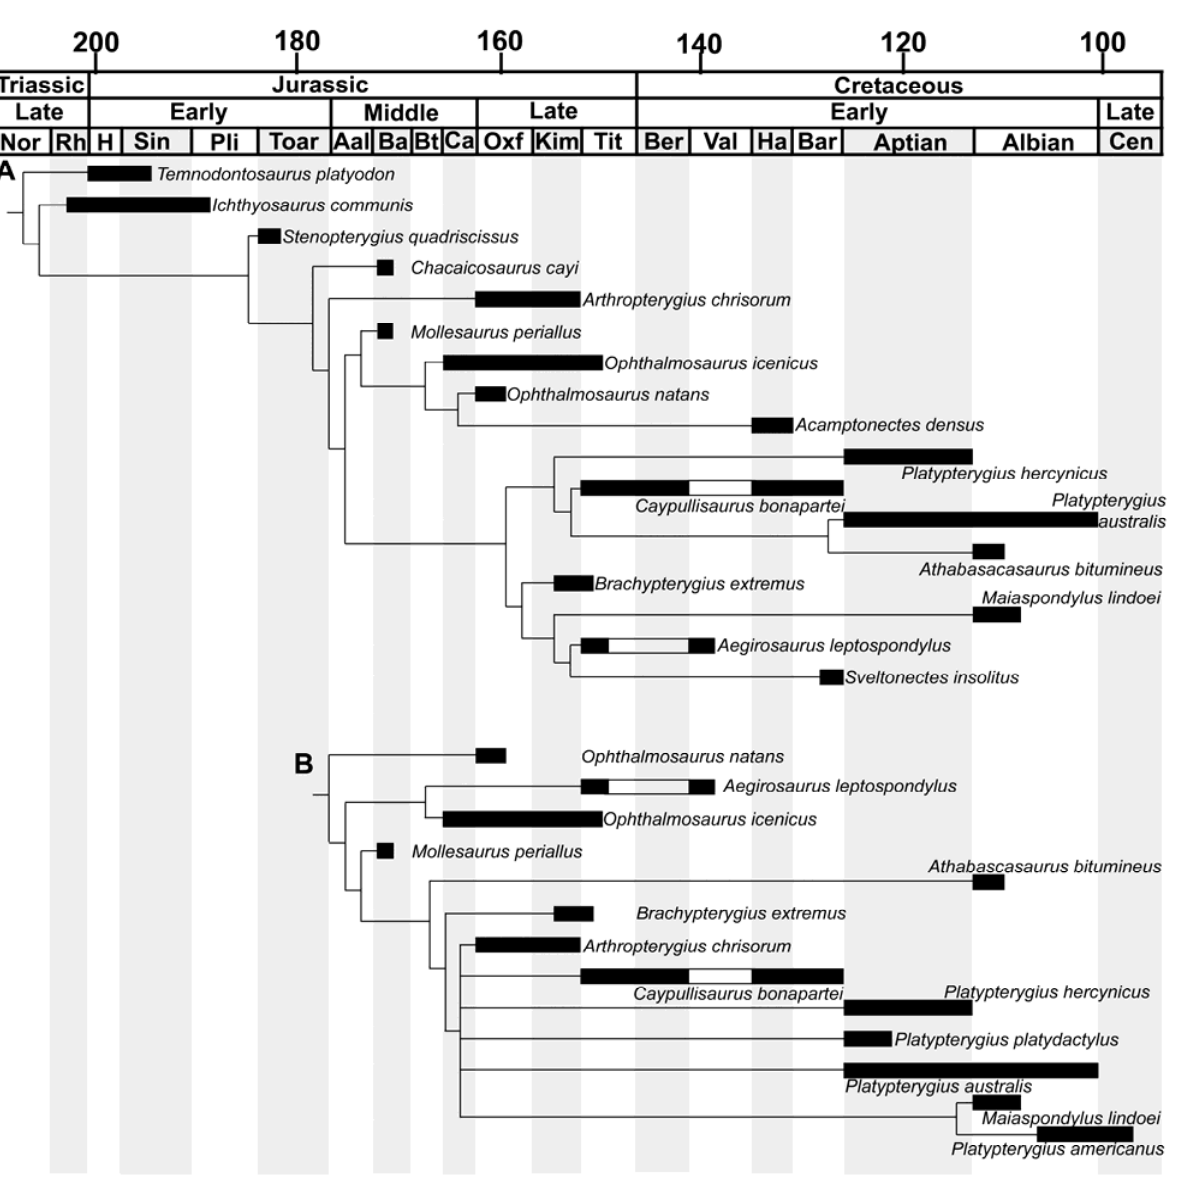
Figure 2. Stratigraphy-related phylogenetic trees. ( A ) modified from Fischer et al. [11]; ( B ) modified from Druckenmiller and Maxwell [9]. Ichthyosaurus communis and Ophthalmosaurus icenicus now extend into the Pliensbachian [69] and Tithonian [62], respectively. Black bars indicate species occurrence within an epoch. White bars indicate a species is not known from this epoch, but occurs in surrounding epochs. Abbreviations: Aal, Aalenian; Ba, Bajocian; Bar, Barremian; Ber, Berriasian; Bt, Bathonian; Ca, Callovian; Cen, Cenomanian; H, Hettangian; Ha, Hauterivian; Kim, Kimmeridgian; Nor, Norian; Oxf, Oxfordian; Pli, Pliensbachian; Rh, Rhaetian; Sin, Sinemurian; Tit, Tithonian; Toar, Toarcian; Val,